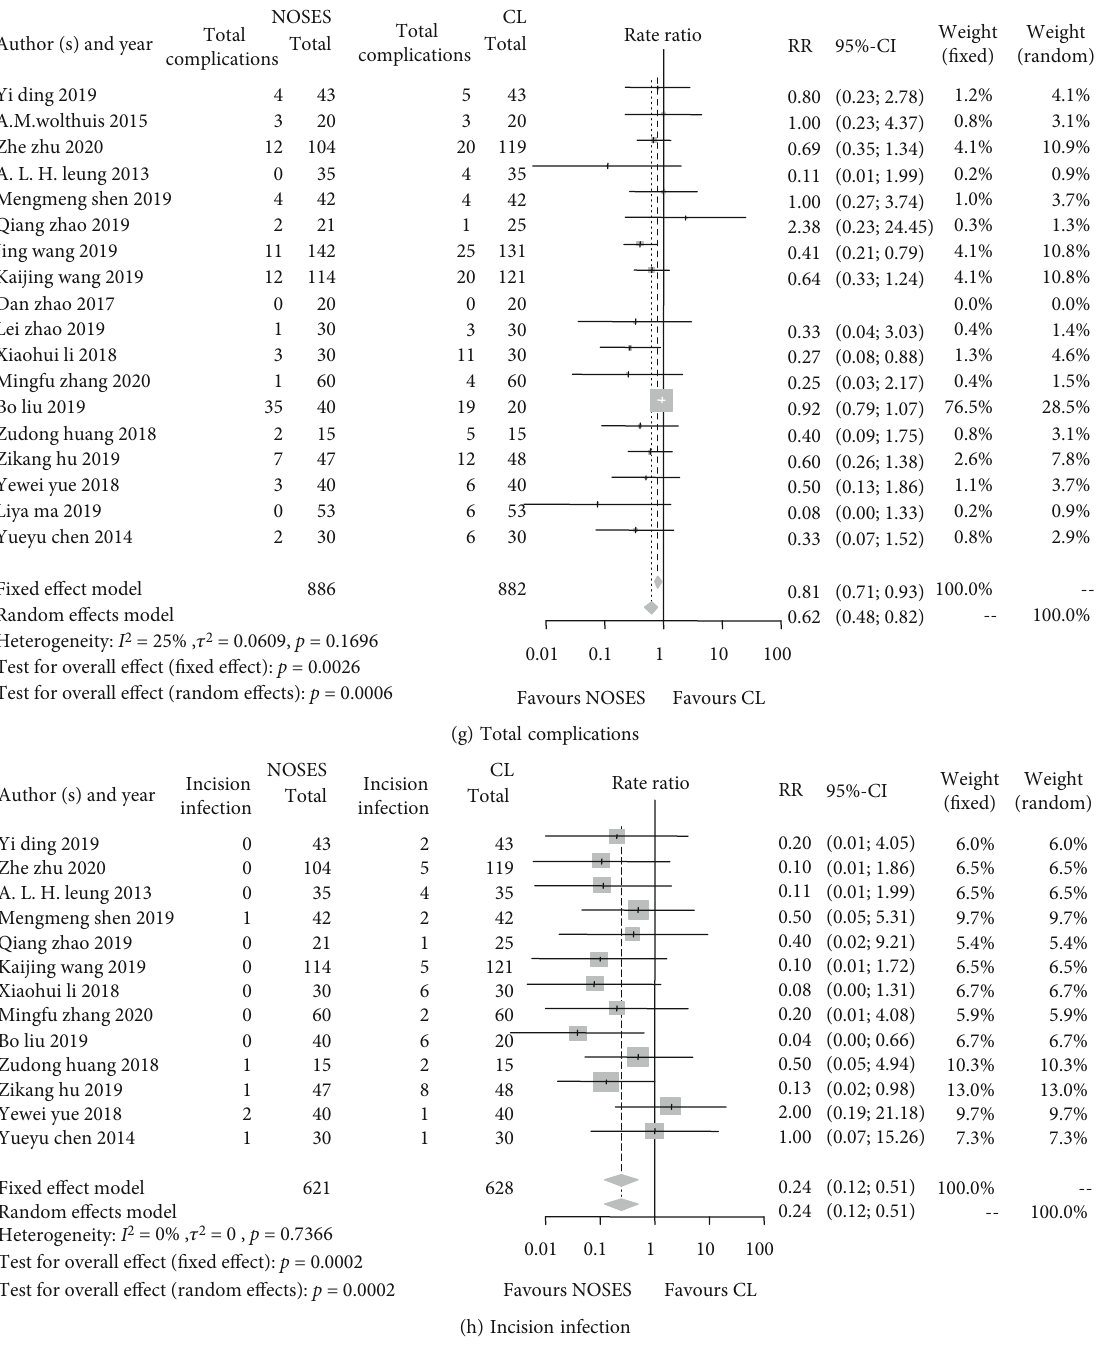
Figure 4: Forest plots of postoperative complications between the NOSE group and the CL group. (a) Anastomotic leakage; (b) ileus; (c) incision bleeding; (d) urinary retention; (e) other complications; (f) infection; (g) total complications; (h) incision